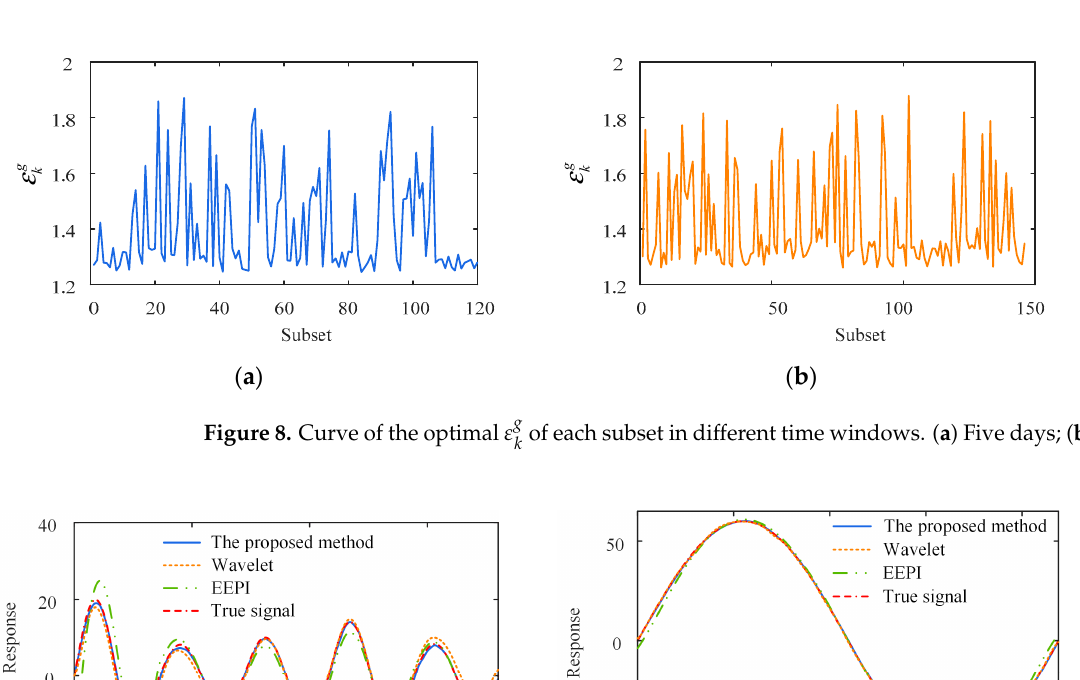
Figure 9. Comparison of separation results in different time windows. ( a ) Five days; ( b ) one year.